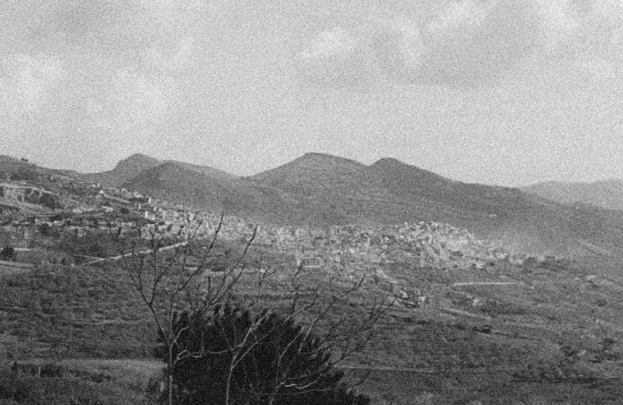
Figure 14. Old Gibellina destroyed by the earthquake. Photo: Archivio de L’Ora, Biblioteca Regionale Siciliana “Alberto Bombace”, Palermo. Photo by the authors, Gibellina 2020.